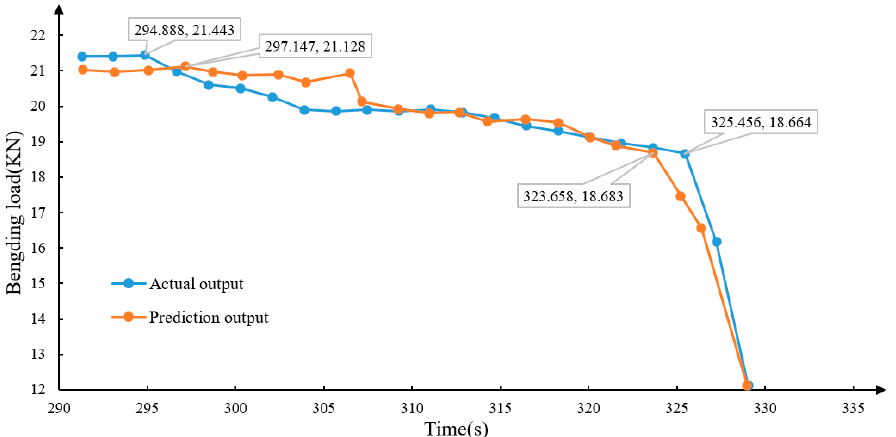
Figure 9. Sample result output of panel performance prediction.